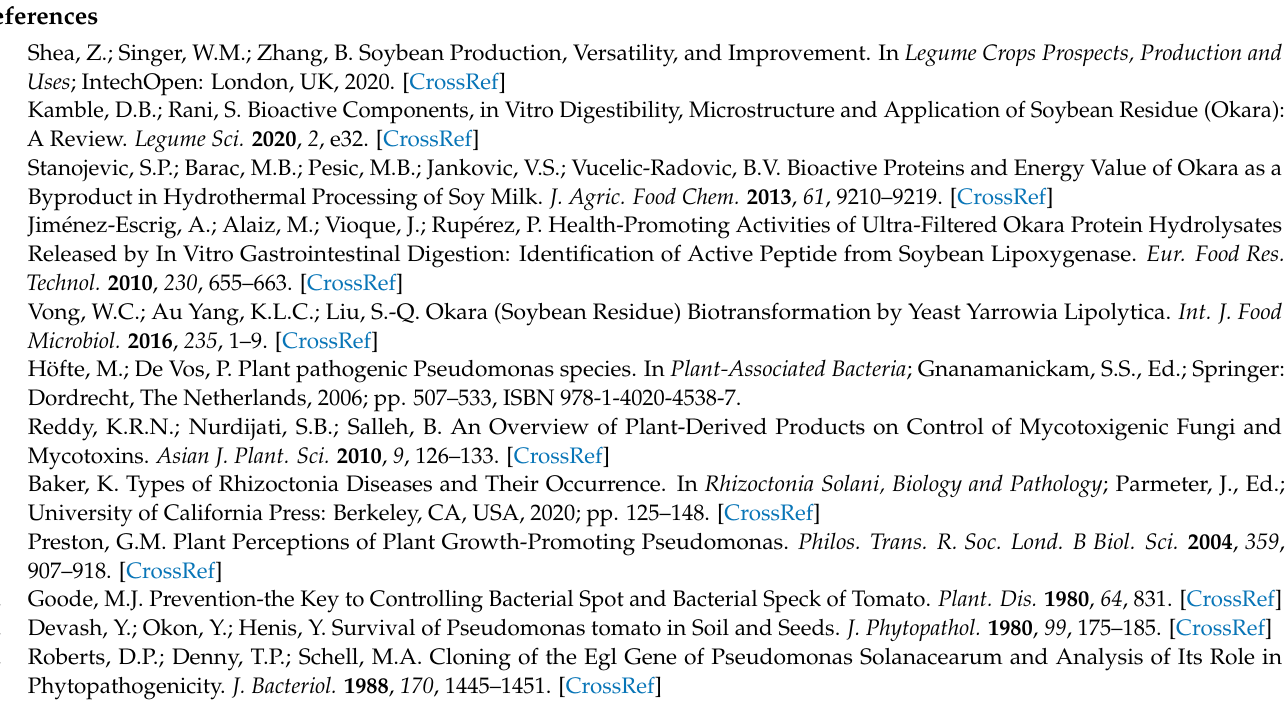
Supplementary Materials: The following are available online. Table S1. Screening of inhibitory activity of the F. graminearum strain of the proteolyzates obtained with different proteolytic enzymes. Table S2. Time-dependent fungi growth inhibition statistical significance. Table S3. Concentration- dependent fungi growth inhibition statistical significance. Figure S1. Size Exclusion Chromatogra- phies (SEC) of OPID (Okara Protein Isolate Digested). Figure S2. Antimicrobial activity pictures. Figure S3. Antimicrobial activity on Pseudomonas solanaceum and P. syringae